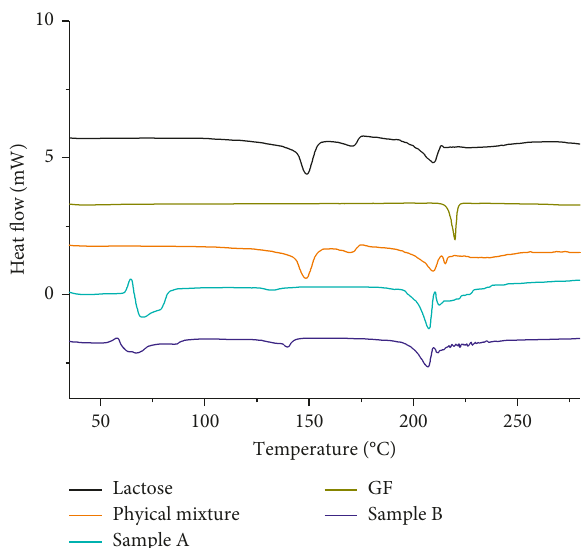
Figure 3: DSC curves of the raw materials, physical mixture, and samples.